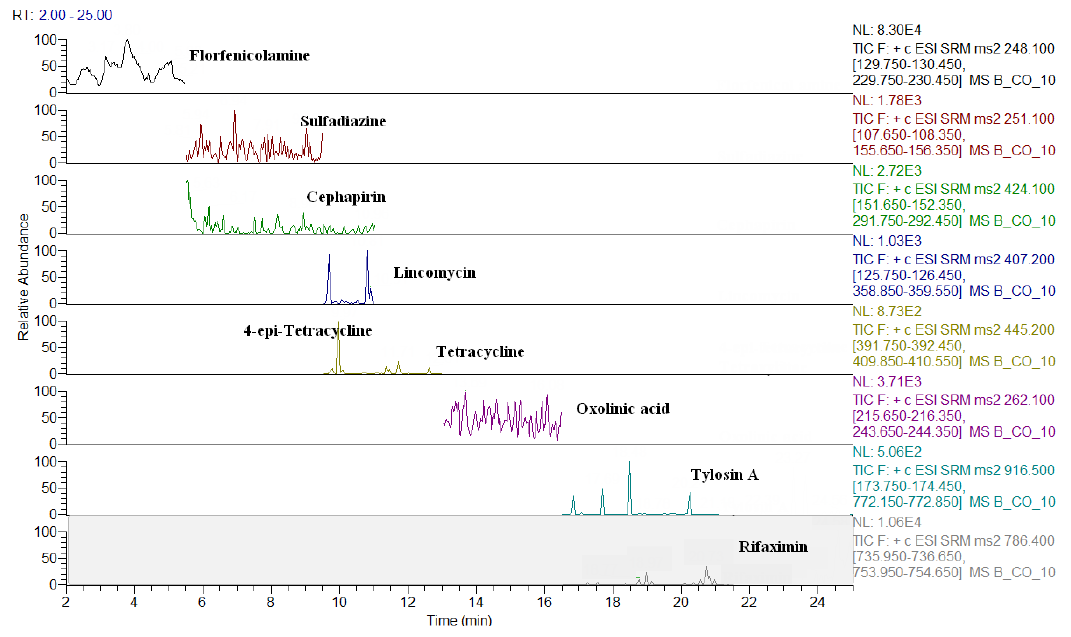
Figure 1. LC-QqQ chromatograms of a blank bovine muscle.